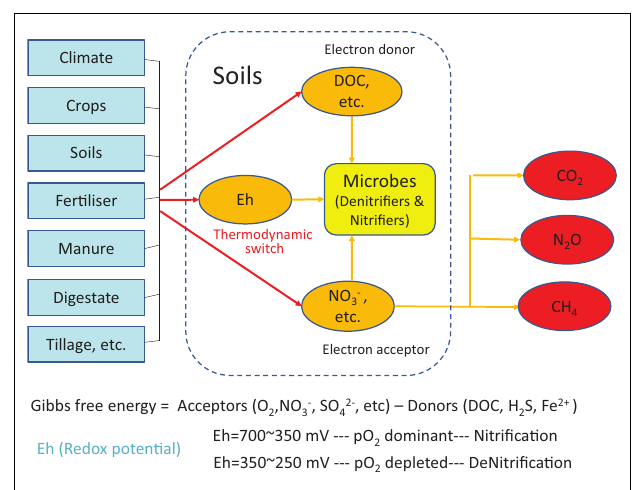
FIGURE 3 | Schematic of digestate model ling in soils .